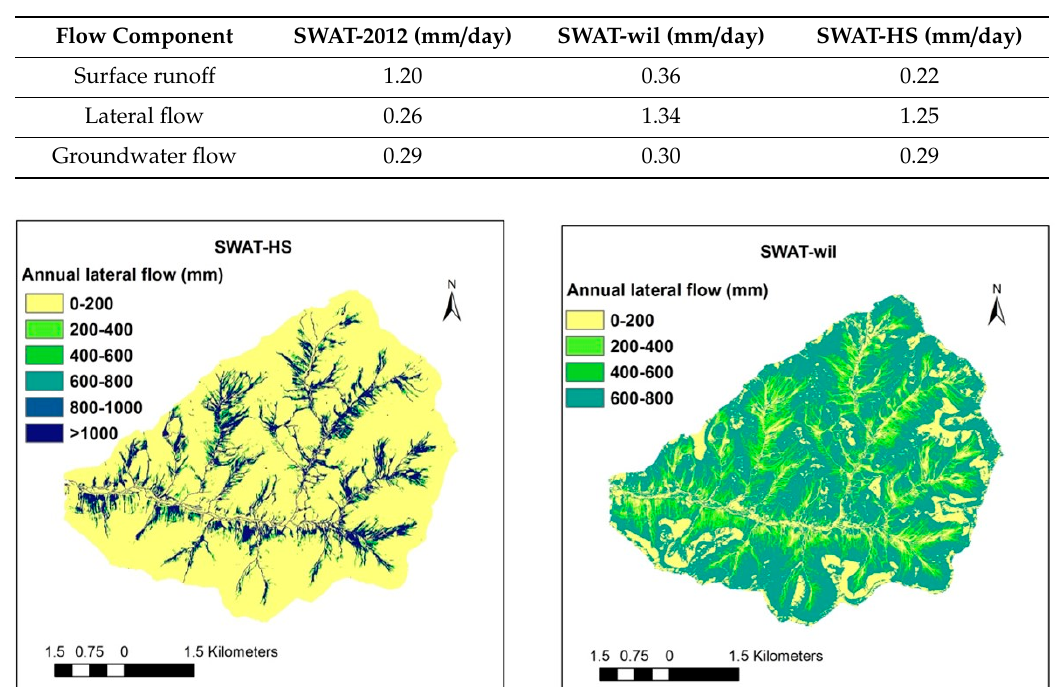
Table 4. Mean daily discharge and stormflow components for 2001–2012 by di ff erent SWAT models.